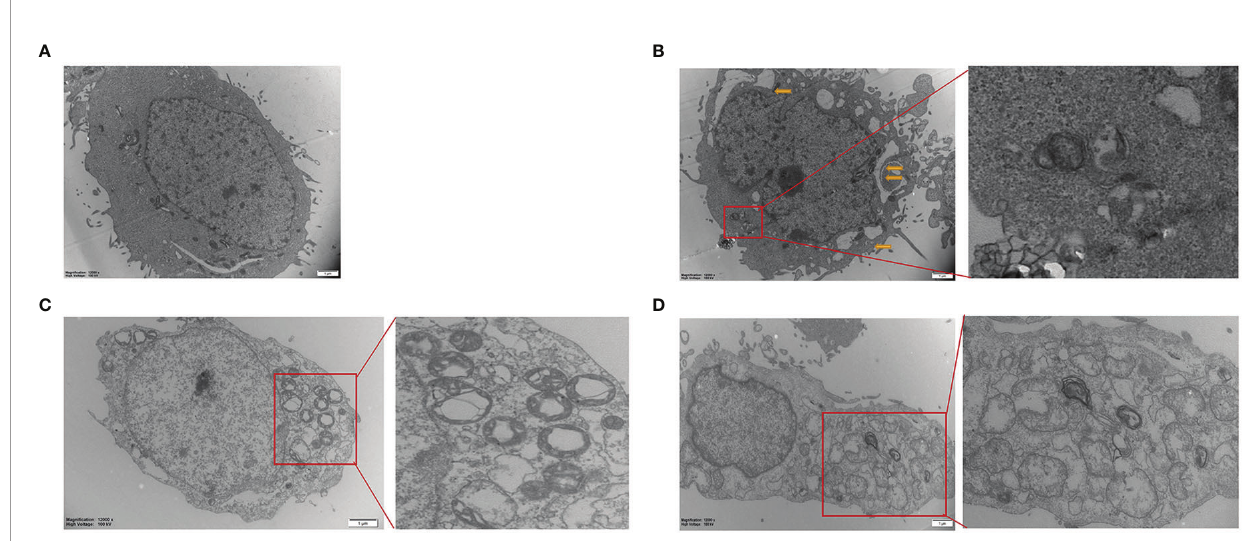
FIGURE 2 | Transmission electron microscope images of Hepa1-6 cells treated with 0 (A) , 25- m M (B) , 50- m M (C) , and 100- m M (D) Sch (B) The yellow arrows are pointing to the mitochondrial swelling, mitochondrial ridge breakage. An enlarged portion of the spectrogram (red box) is shown on the right showing vacuolar and cytoplasmic localized membrane-bound autophagosome.